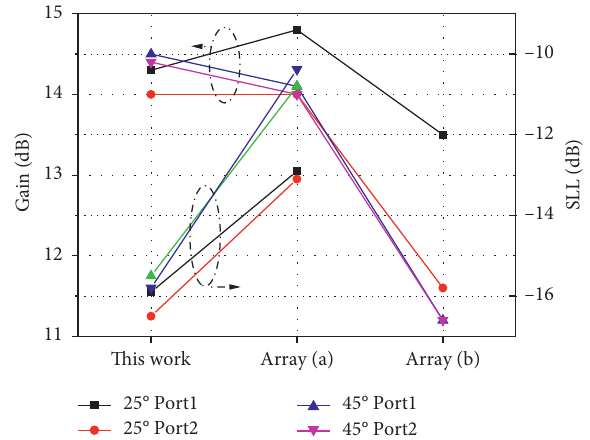
Figure 13: Gain fluctuation and SLL of three classes of arrays.